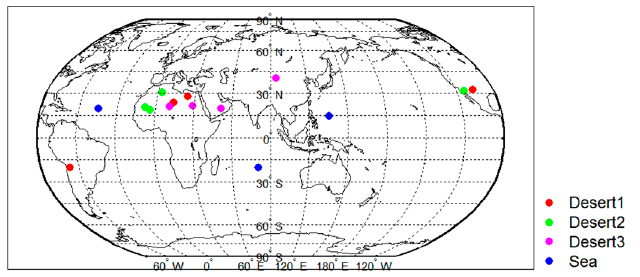
Figure 4. Locations of the calibration sites used in this study.